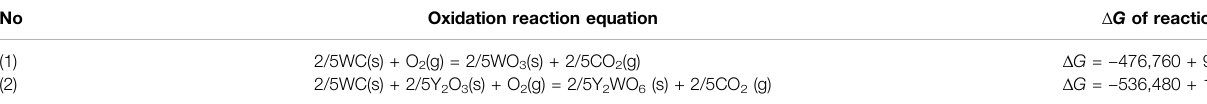
TABLE 3 | Oxidation reaction equations and corresponding change of Gibbs free energy ( Δ G ) in WC-Y 2 O 3 cemented carbide.